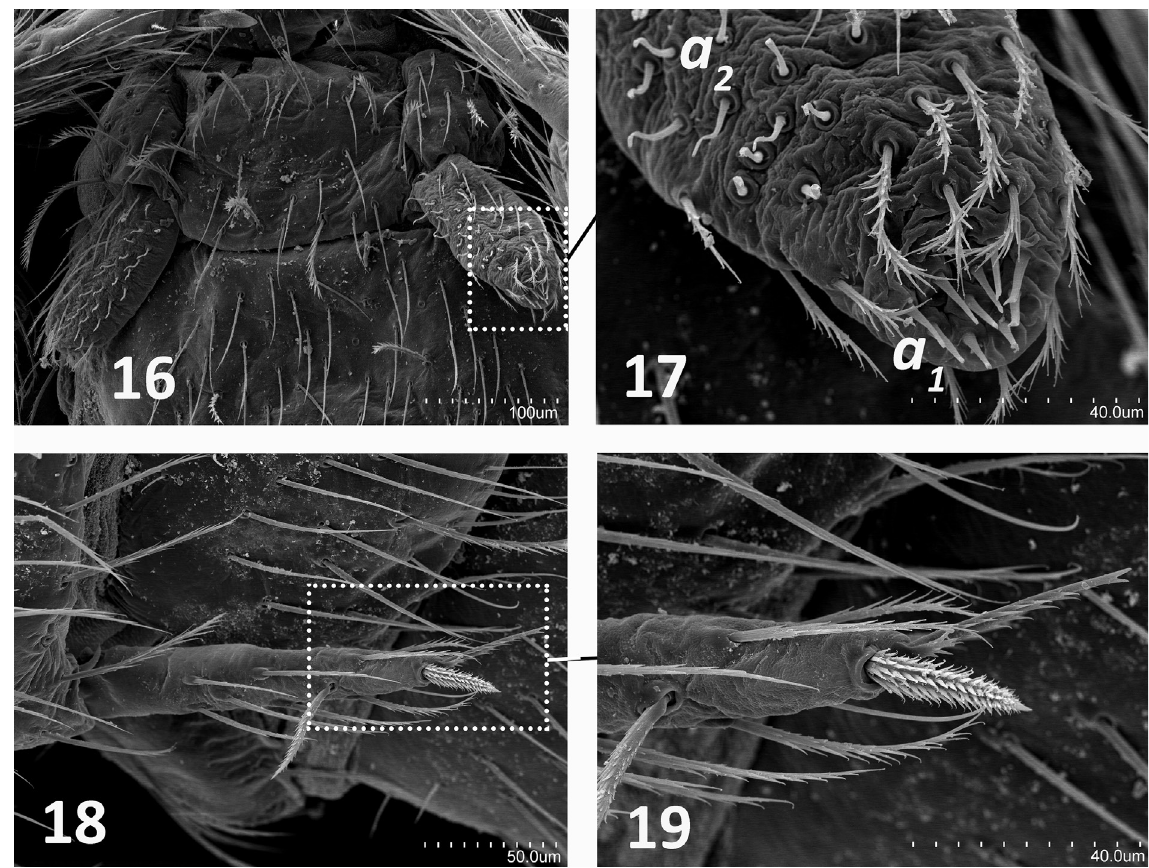
17 . Detail of the appendage of the first urosternite in a female with glandular a of the lateral right side of the fifth urosternite. 19 . Detail of the stylus of the lateral right side of the fifth